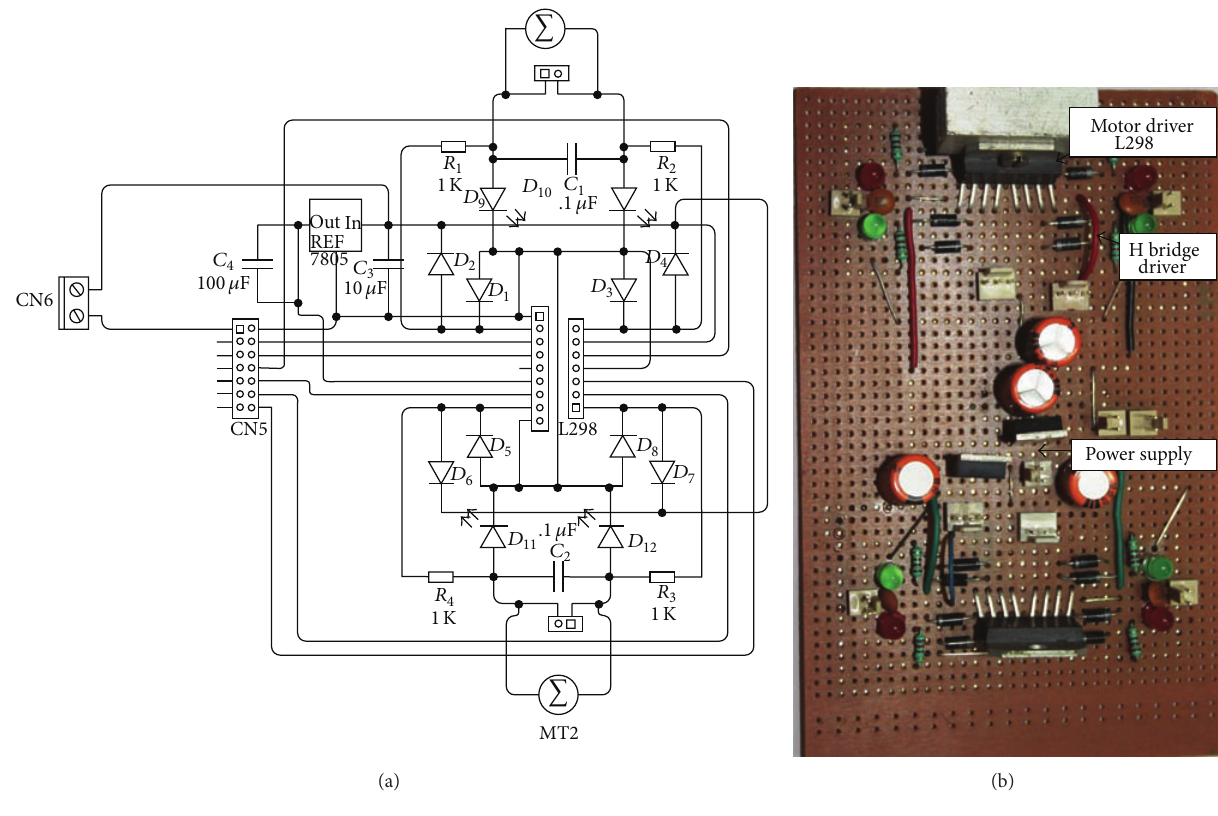
Figure 17: (a) Schematic design of motor driver circuit. (b) Developed motor driver circuit.